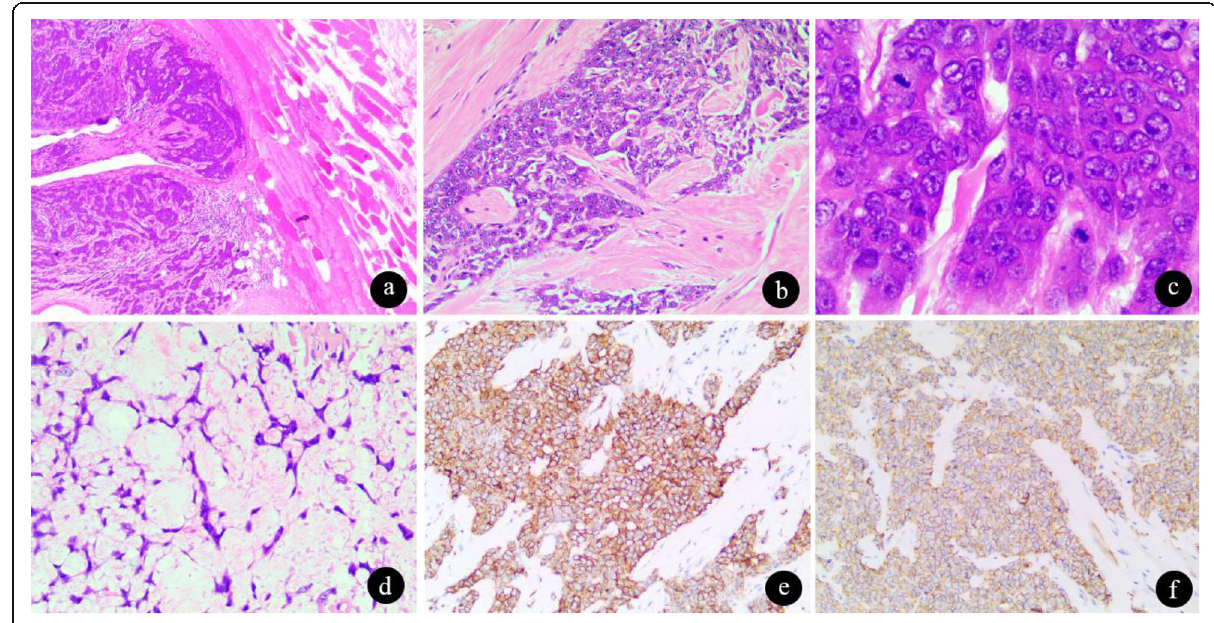
Fig. 3 The microscopic and immunohistochemical features. a The tumor cells were arranged in a nodular shape and showed infiltrating growth into the surrounding fat and muscle tissue (H&E, × 100). b The nodules were separated by a large volume of fibrous tissues (H&E, × 200). c : Cells showed uniform size, round nuclei, nonobvious entoblasts, and slightly stained cytoplasm, and mitosis could be seen in highly cellular areas (H&E, × 400). d In a few nodules, the cells were loosely arranged and connected into a reticulated or crossed appearance in the myxoid stroma (H&E, × 100). e Immunohistochemically, the tumor cells were positive for CD117(× 200). f Immunohistochemically, the tumor cells were positive